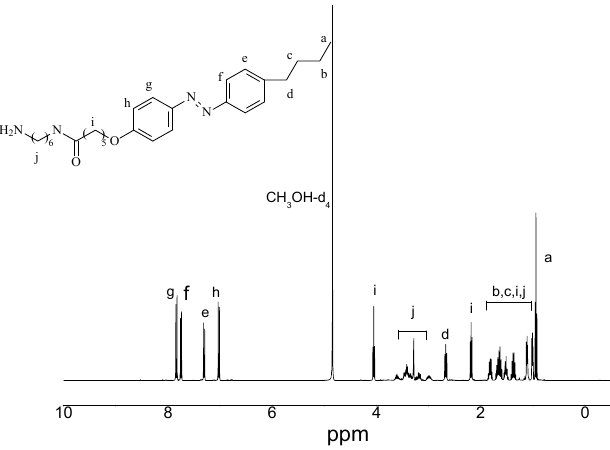
Figure 3. 1 H NMR spectrum of C4-Azo-C5-HDA in CH 3 OH-d 4 .